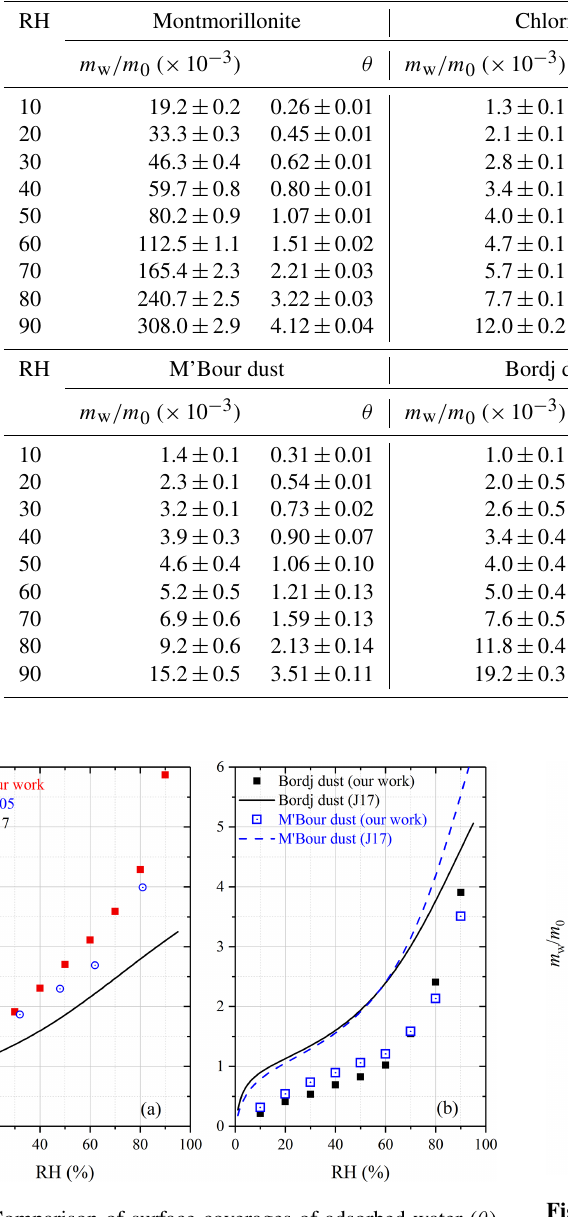
Figure 8. Comparison of surface coverages of adsorbed water ( θ ) reported in different studies for (a) ATD and (b) Bordj dust and M’Bour dust. G05, Gustafsson et al. (2005); J17, Joshi et al. (2017). Bordj dust and M’Bour dust. As suggested by Fig. 8b, the relative differences between our and their work (Joshi et al., 2017) were usually within a factor of 2 for the two dust sam- ples, and the discrepancy also became smaller at higher RH, suggesting fair consistency between the two studies.